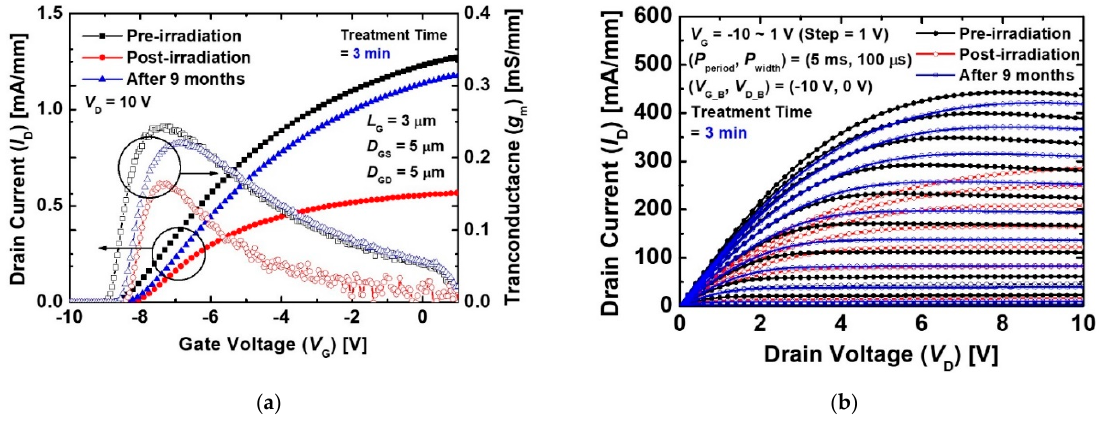
Figure 9. ( a ) I D and g m characteristics as a function of V G at a low V D of 0.1 V and ( b ) gate ‐ lag characteristics of the MIS ‐ HEMTs with treatment for 3 min before and after irradiation, and after nine months.